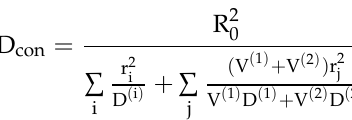
Figure 7. Homogenized concrete of chloride diffusivity D con .